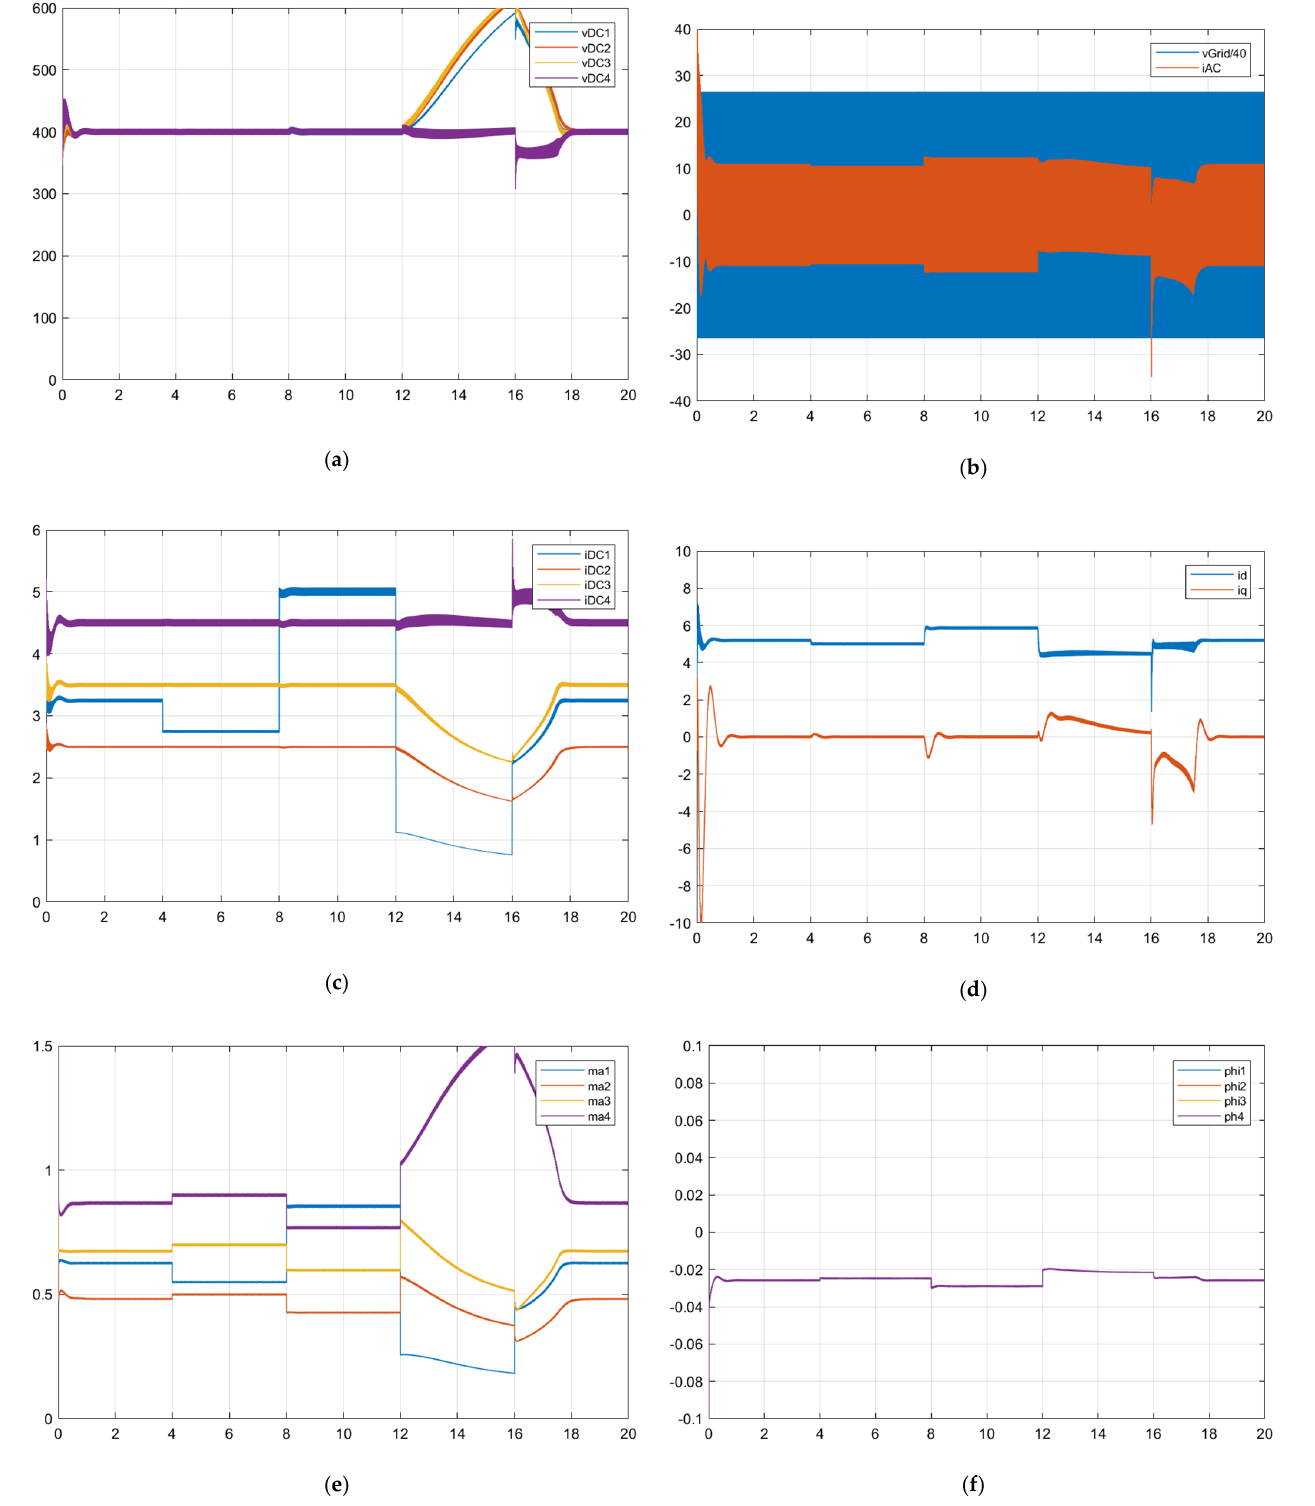
Figure 9. Simulation results when using normal operation (GUPF) strategy for case B: ( a ) PEB output DC voltage, ( b ) PEB output DC current, ( c ) grid voltage and current, ( d ) grid d–q current components, ( e ) PEB amplitude modulation index and ( f ) PEB modulation waveform phase.